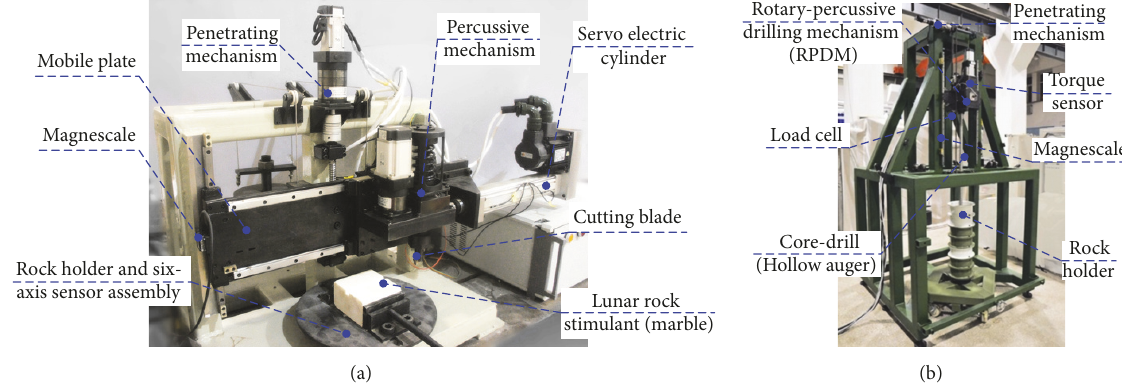
Figure 8: Single-blade linear cutting load test platform (a) and comprehensive drill characteristics test platform